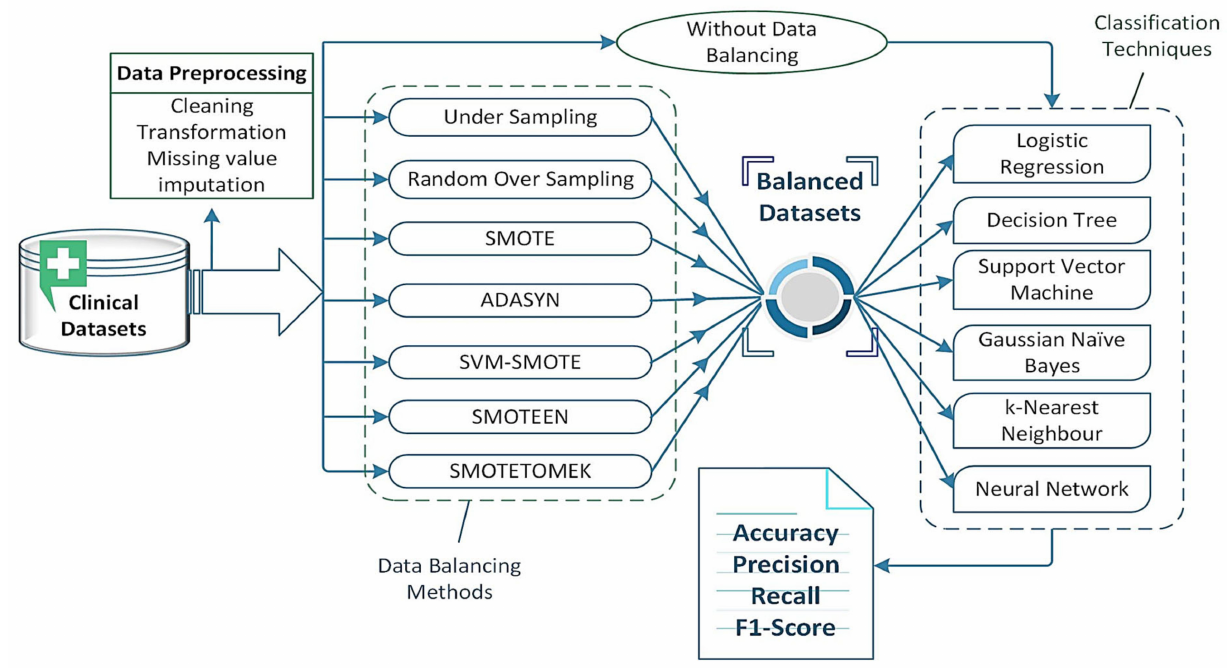
Figure 4. Experimental setup for evaluation of classifiers over clinical